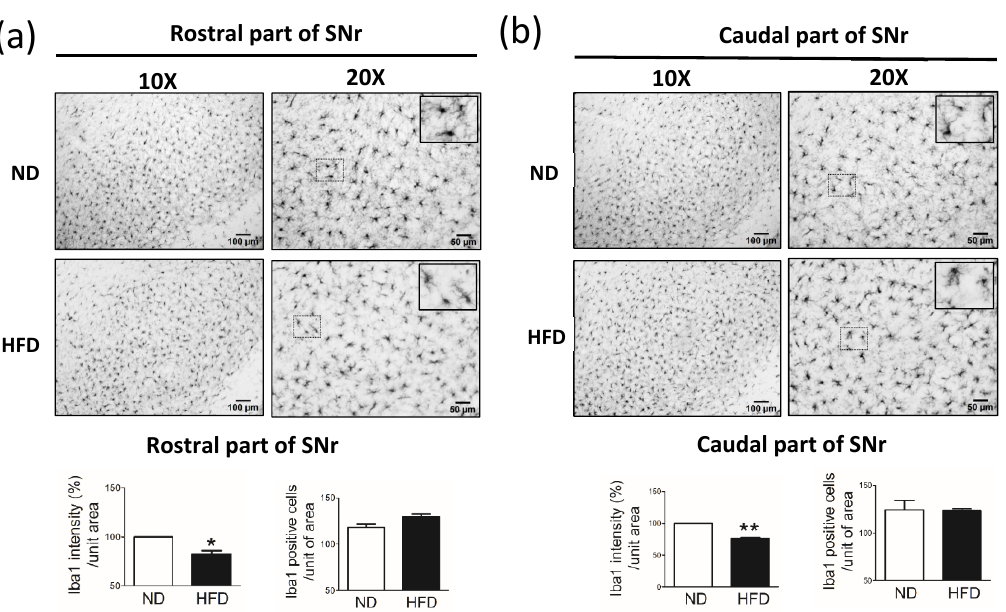
Figure 9. Immunostaining of microglial cells (IbA1-positive cells) in the substantia nigra pars reticularis (SNr) after rats were fed a normal diet (ND, control, n = 5) or 45% high-fat diet (HFD, n = 5) for 30 weeks. Data were captured with 10X (scale bar = 100 µ m) and 20X (scale bar = 50 µ m) objectives. Immunostaining for IbA1 (microglial cells) in the ( a ) rostral part of the SNr and ( b ) caudal part of the SNr. IbA1 immuno-intensity (%) and IbA1-positive cells per unit of area (20X objective) were quantified by using cellSens Dimension software (Olympus). Data are expressed as the mean ± SEM. * p < 0.05, ** p < 0.01 vs ND rats ( t- test).